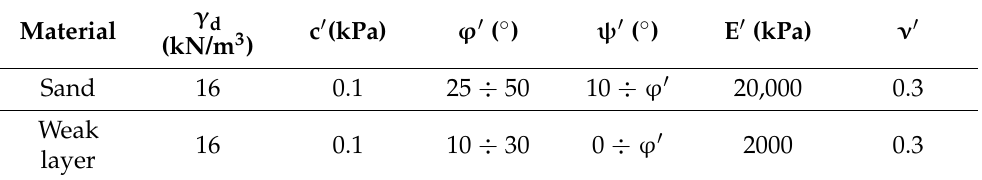
Table 2. Mechanical parameters of the materials. γ d : dry unit weight; c (cid:48) : effective intercept cohesion; ϕ (cid:48) : effective shear strength angle; ψ (cid:48) : dilation angle; E (cid:48) : Young modulus; ν (cid:48) : Poisson (cid:48) s ratio.